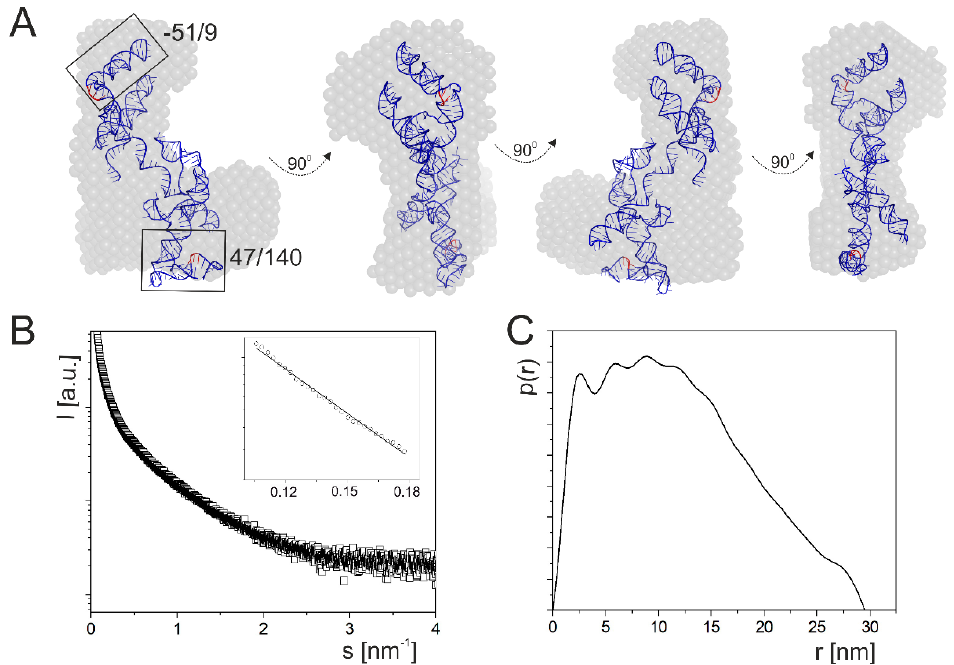
Figure 4. Spatial structure of the 5 ′ -terminal region of mouse p53 mRNA. ( A ) The SAXS-derived ab initio envelope for p53 mRNA fragment RNA-122/201 is superimposed with its tertiary structure generated by RNAComposer. ( B ) Experimental SAXS curve collected for RNA-122/201 and Guinier plot (insert). ( C ) Pair distribution function shows an elongated RNA shape.